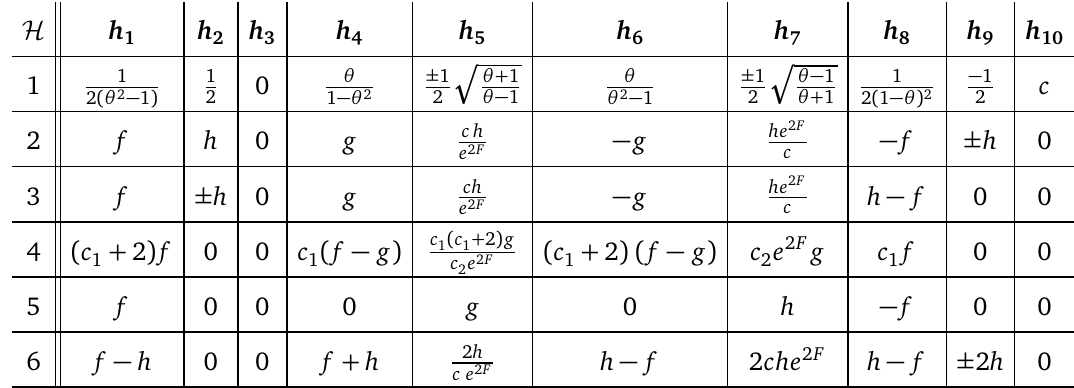
Table 4: All non-difference models with h θ dependent functions by f , g , h , F and F (cid:48) = f . We have omitted the explicit θ dependence in the latter